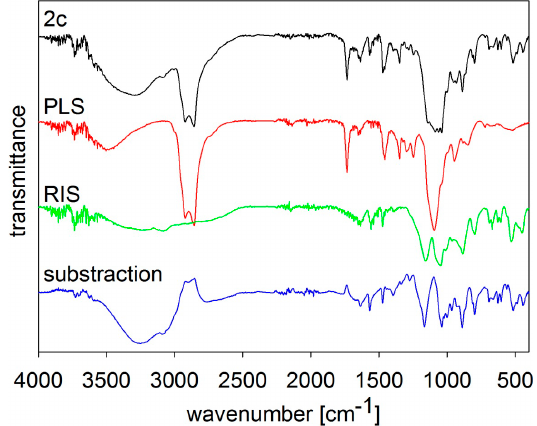
Figure 3. MIR spectra of risedronate (RIS), polysorbate 80 (PLS) and risedronate nanoparticles stabilized with 5% concentration of polysorbate 80 (Sample 2c ) and differential spectrum.